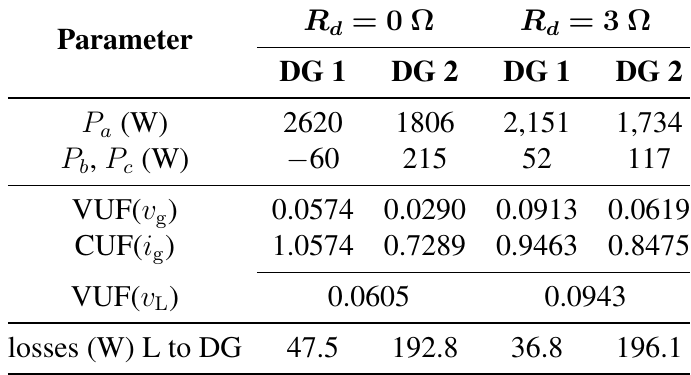
Table 9. Islanded microgrid: power sharing between two DG units with different R